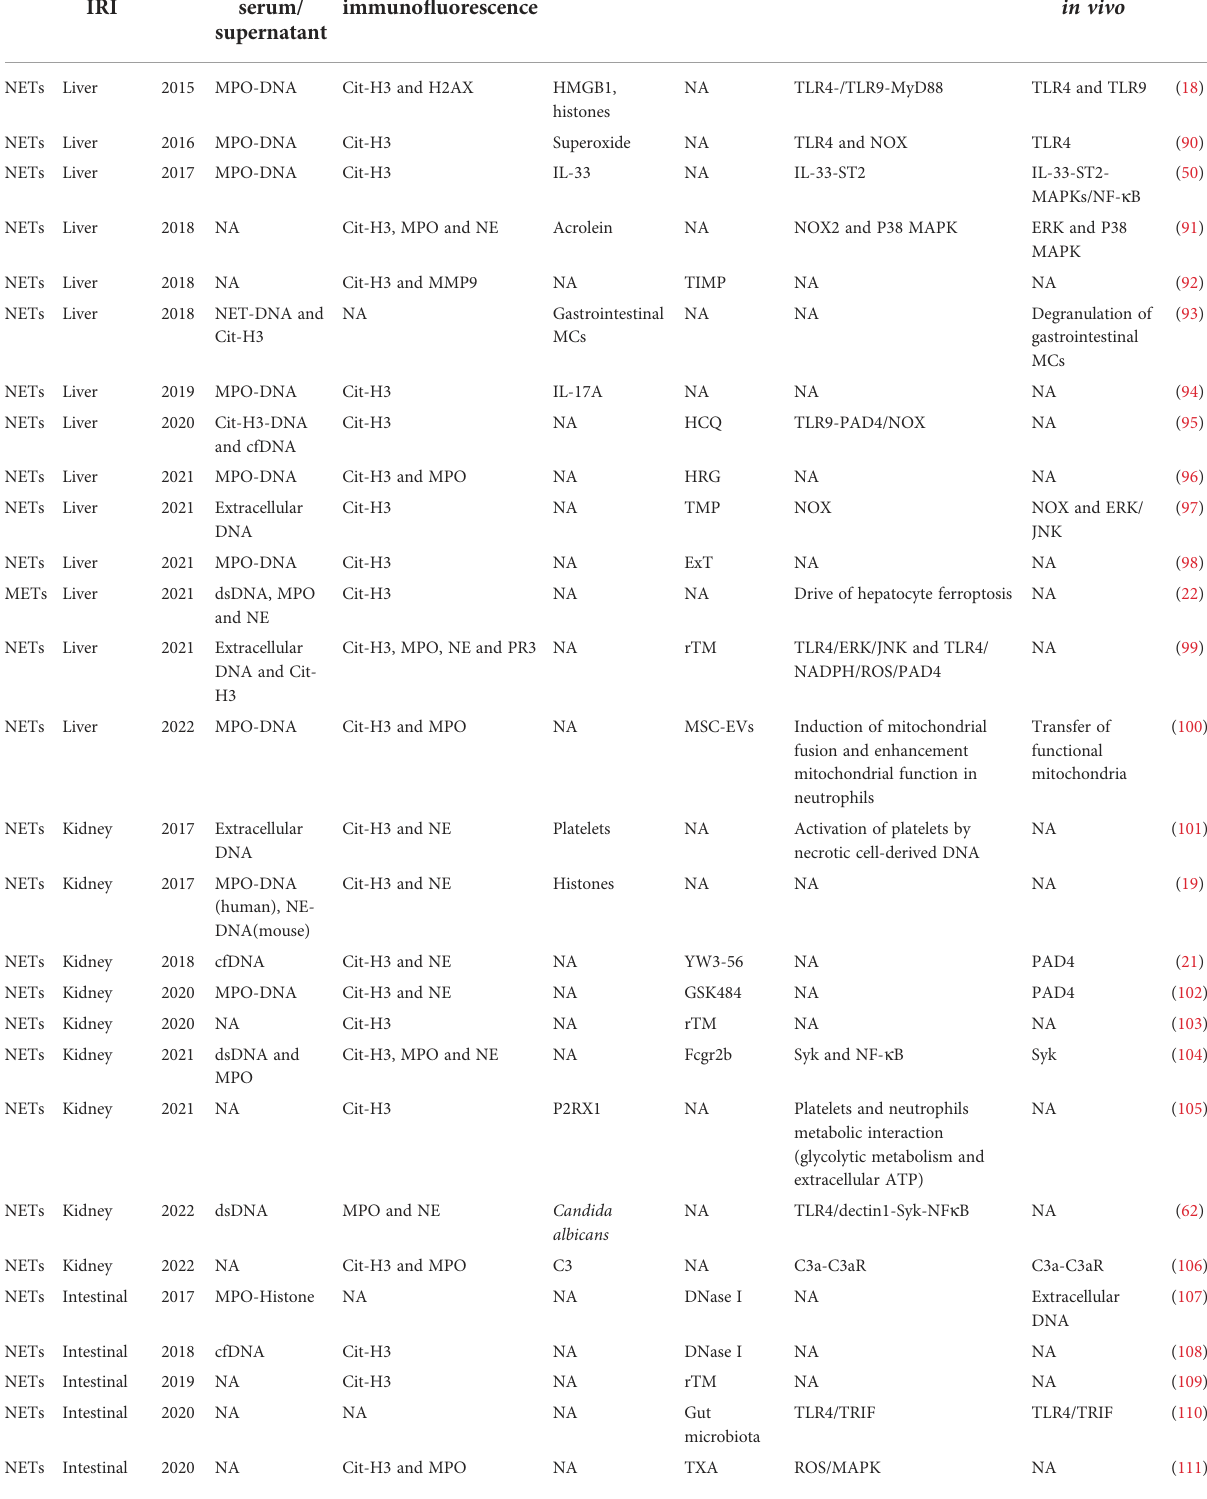
TABLE 1 Markers and mechanisms of extracellular trap induction and inhibition in organ IRI.